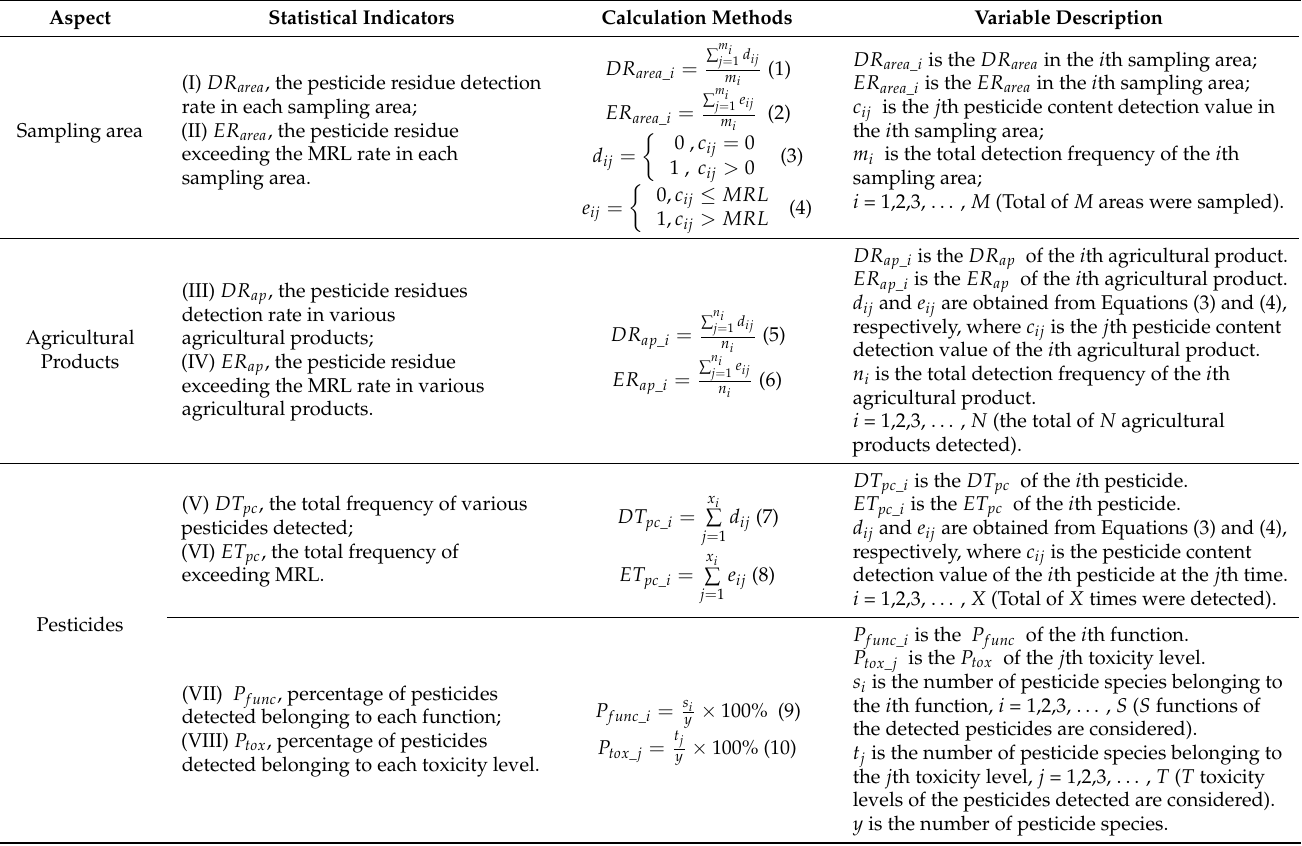
Table 3. Statistical indicators and calculation